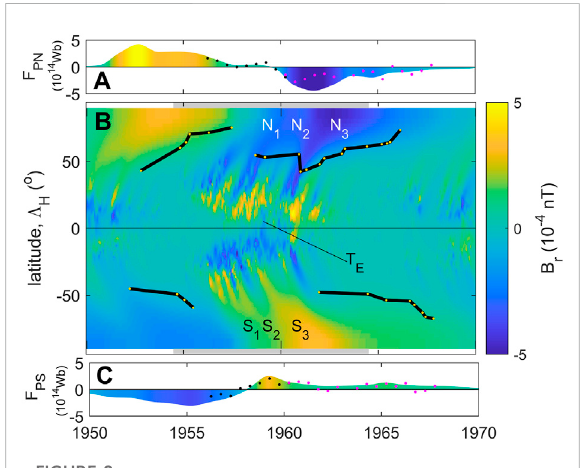
FIGURE 8 Detail of Figure 7 for solar cycle 19 at the peak of the Modern GrandSolarMaximum.Inpart (B) N 1 , N 2 and N 3 are threepoleward surge features of fl ux transport in the northern hemisphere and S 1 , S fl ux S 2 and 3 are the corresponding features of poleward transport in the southern hemisphere. The feature labelled T E appears to show transequatorial transfer of toward polarity ( B r < 0) fl ux.Inthetopandbottompanels (A,C) ,thecolouredvariationsare the polar fl uxes from MWO images of polar faculae, black dots show the 6-months averages of the polar fi eld measured by the Hale Solar Observatory (HSO) magnetograph (from Babcock, 1959)andthemauvedotsare6-monthsaveragesofthepolar fi eld measured by the fi rst magnetograph atMount Wilson Observatory (MWO) (from Howard, 1972). In both cases, the polar fi elds have been scaled to the polar cap fl uxes F PN and F PS using a scaling factor of 4 × 10 18 Wb nT − 1 . The gray portions of the bars at the top and bottom of Part (B) denote sunspot cycle